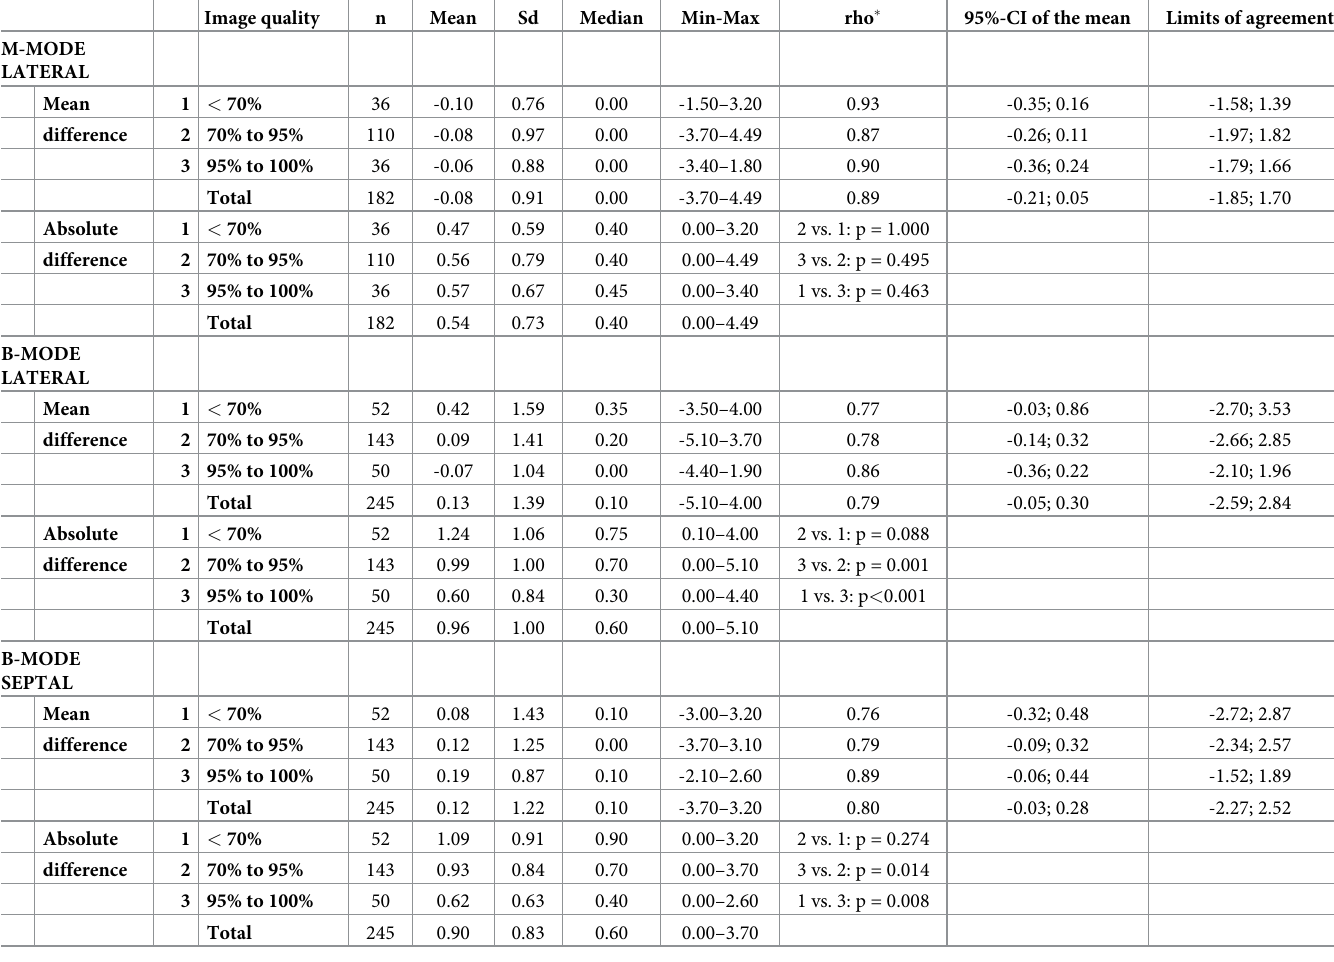
Table 3. Interobserver reproducibility of MAPSE measurements in relation to echocardiographic image quality. P-values were calculated with the Mann-Whitney- U-Test. Image